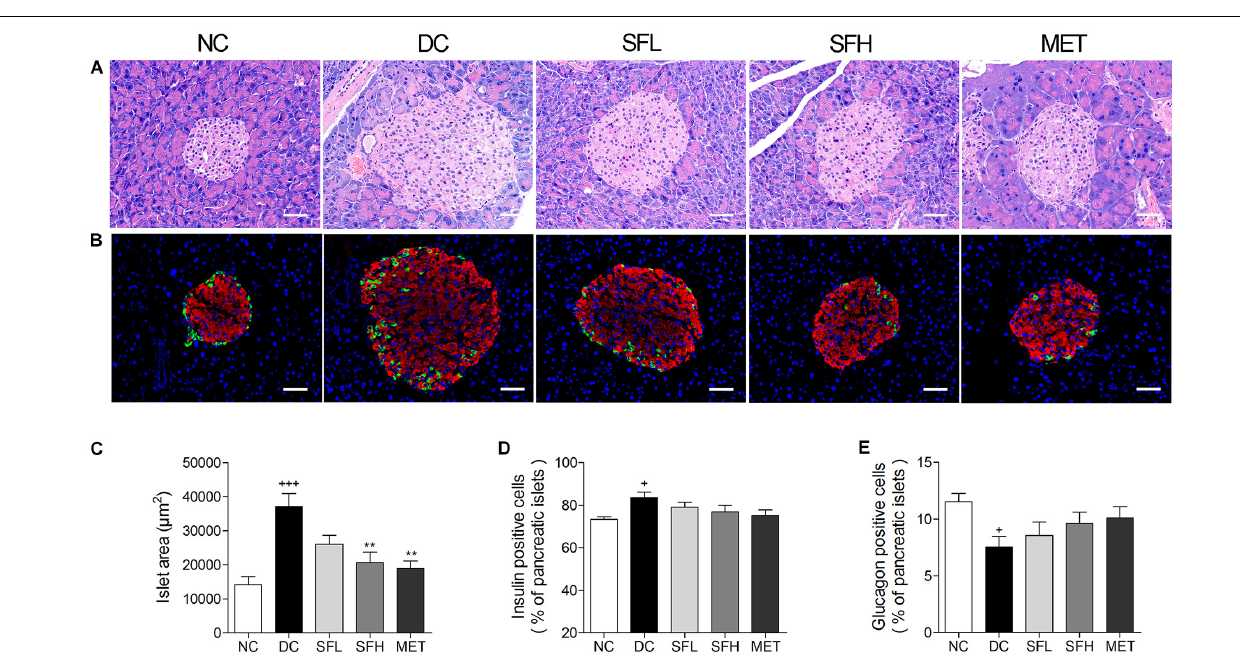
( Figure 3 ). These results suggested that SD-FRE is beneficial in enhancing insulin sensitivity in KK-Ay